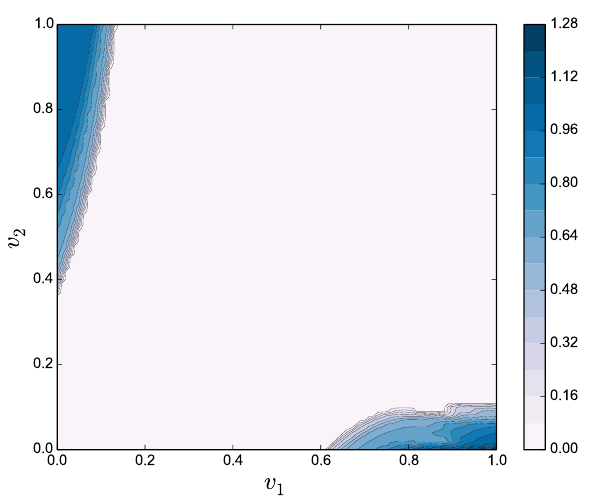
Fig. 4 Level sets of h ( f v ) in bits vs v 1 , v 2 , 0 ≤ v 1 , v 2 ≤ 1 and v 1 (cid:54) = v 2 ( ε = 10 − 4 , ∆ v 1 = ∆ v 2 = 0 . 1 , v 2